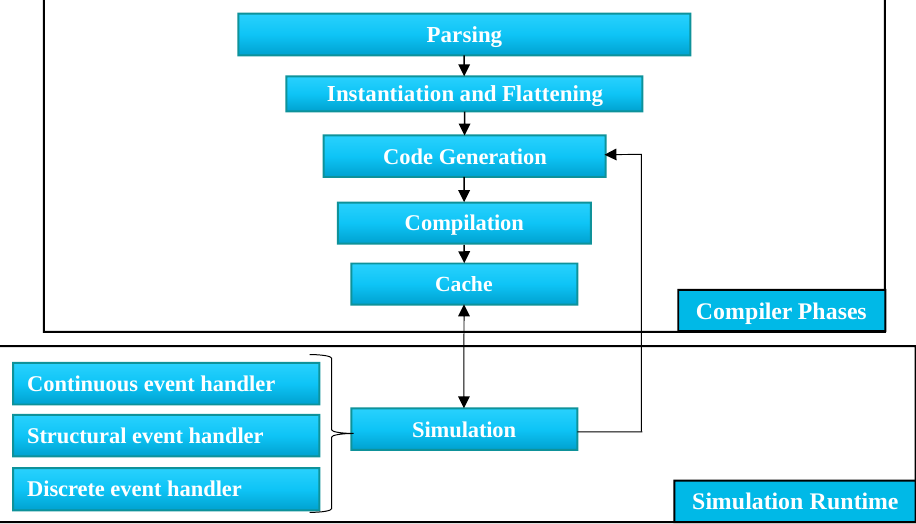
Figure 5. The compilation process of a JIT capable Modelica compiler. During simulation, a structural change may trigger recompilation, and re-initialization of the system that is